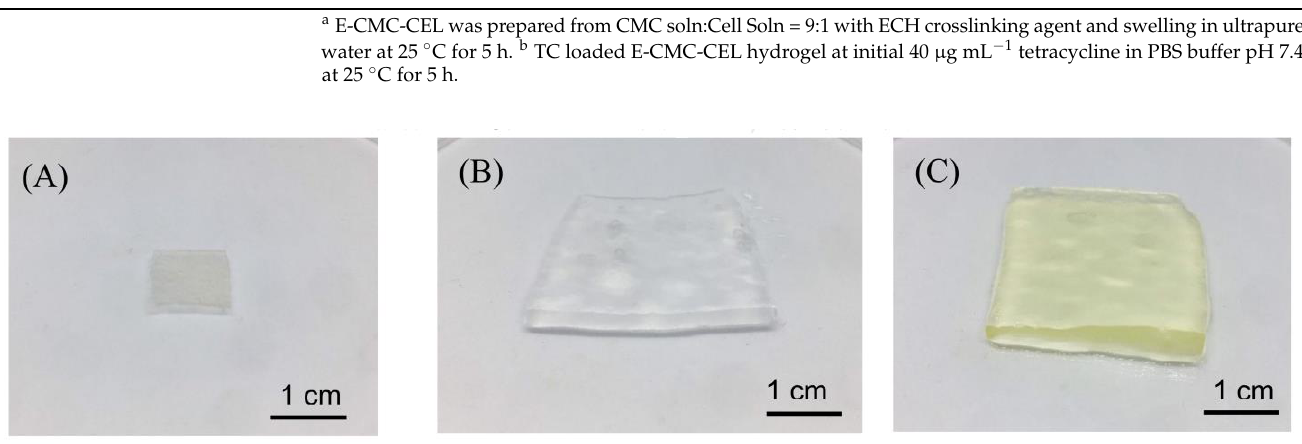
Figure 12. E-CMC-CEL hydrogel ( A ) before swelling, ( B ) swelling in ultrapure water at 25 ◦ C for 2 h, and ( C ) swelling in tetracycline solution at 40 µ g mL − 1 initial TC concentration at 25 ◦ C for 2